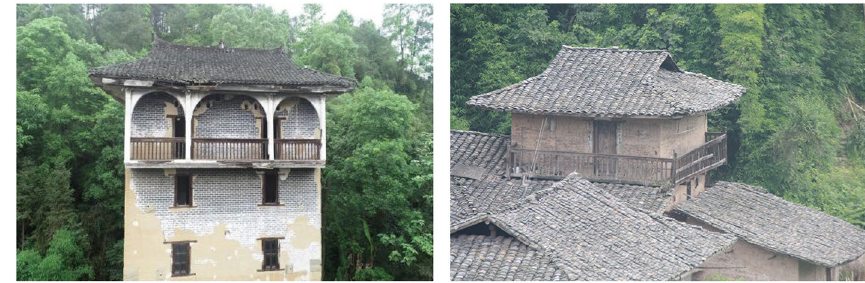
Fig. 10 Viewing platform around the top of the watchtower house in Ba ′ nan and Jiangjing, Chongqing (Source: the